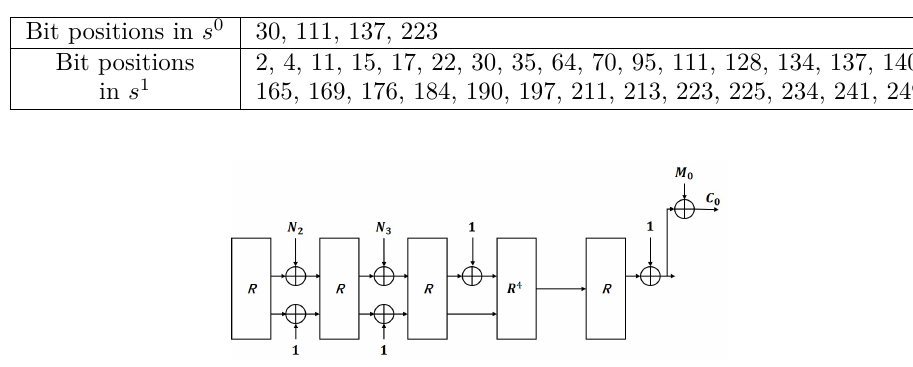
Table 5: Cube variables for cube tester